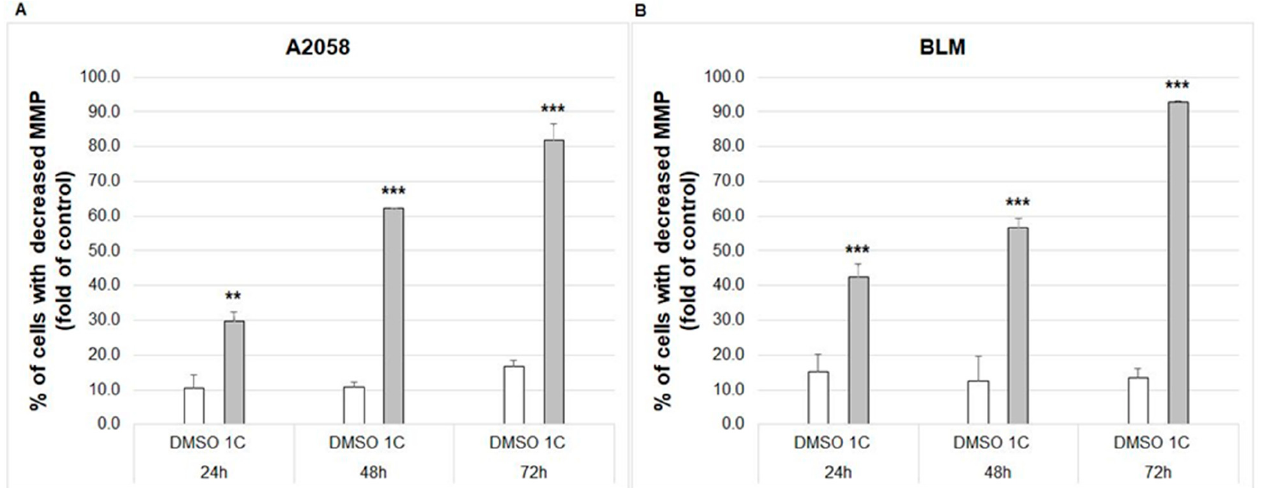
Figure 9. Flow cytometric analysis of changes in mitochondrial membrane potential (MMP) in A2058 ( A ) and BLM ( B ) melanoma cells after 24, 48 and 72 h of treatment with chalcone 1C at concentrations of 10 µ mol/L (A2058) and 20 µ mol/L (BLM). The data show the mean ± SD values of three independent experiments. Statistical significance: ** p < 0.01, *** p < 0.001 vs. DMSO (vehicle).